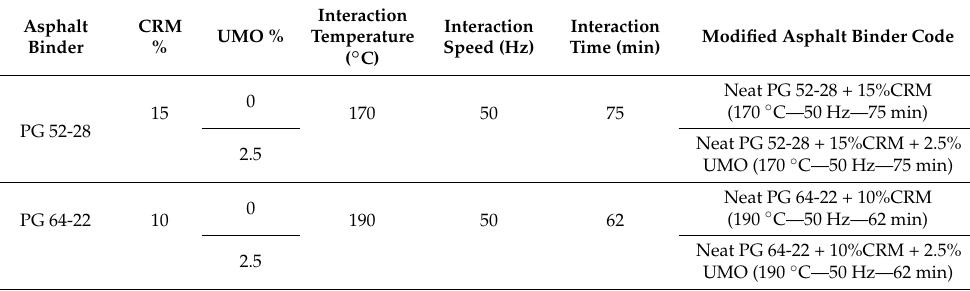
Table 4. Interaction conditions for the modified asphalt